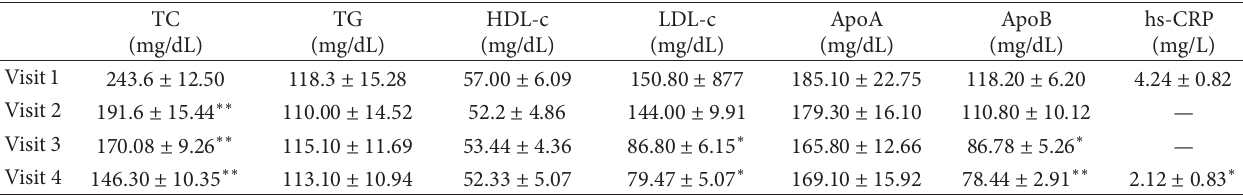
Table 3: Lipid, lipoprotein, and hs-CRP profile of patients during the study. Values are expressed as mean ± standard error (SEM). ∗ 𝑃 < 0,05 and ∗∗ 𝑃 < 0,01 versus visit 1.